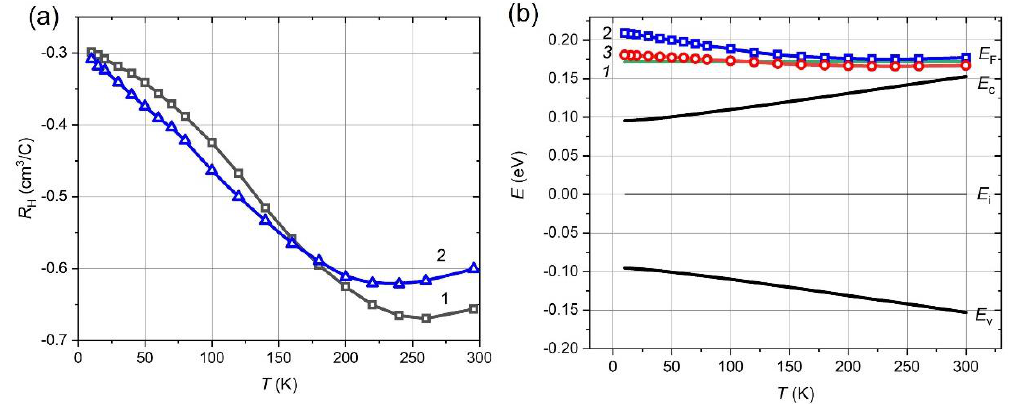
Figure 4. ( a ) Hall coefficient as a function of temperature for as-grown PbTe:In films with different doping level: 1 — Pb 0.99 In 0.01 Te, 2 — Pb 0.995 In 0.005 Te; ( b ) Reconstructed band energy structure of PbTe on temperature using measured Hall concentration. E V — valence band ceiling, E C — bottom of the conduction band, E i — middle of the bandgap. 1 — theoretically predicted Fermi level, 2 — calculated Fermi level, using parabolic Kane’s model, 3—calculated Fermi level, using non-parabolic Cohen’s model.